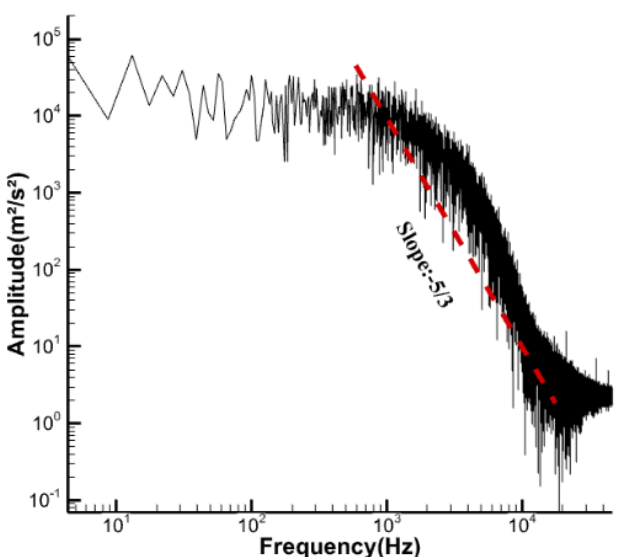
Figure 4. Spectrum of instantaneous axial velocity at point P.